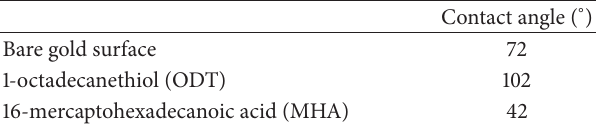
Table 1: Contact angles of water on different